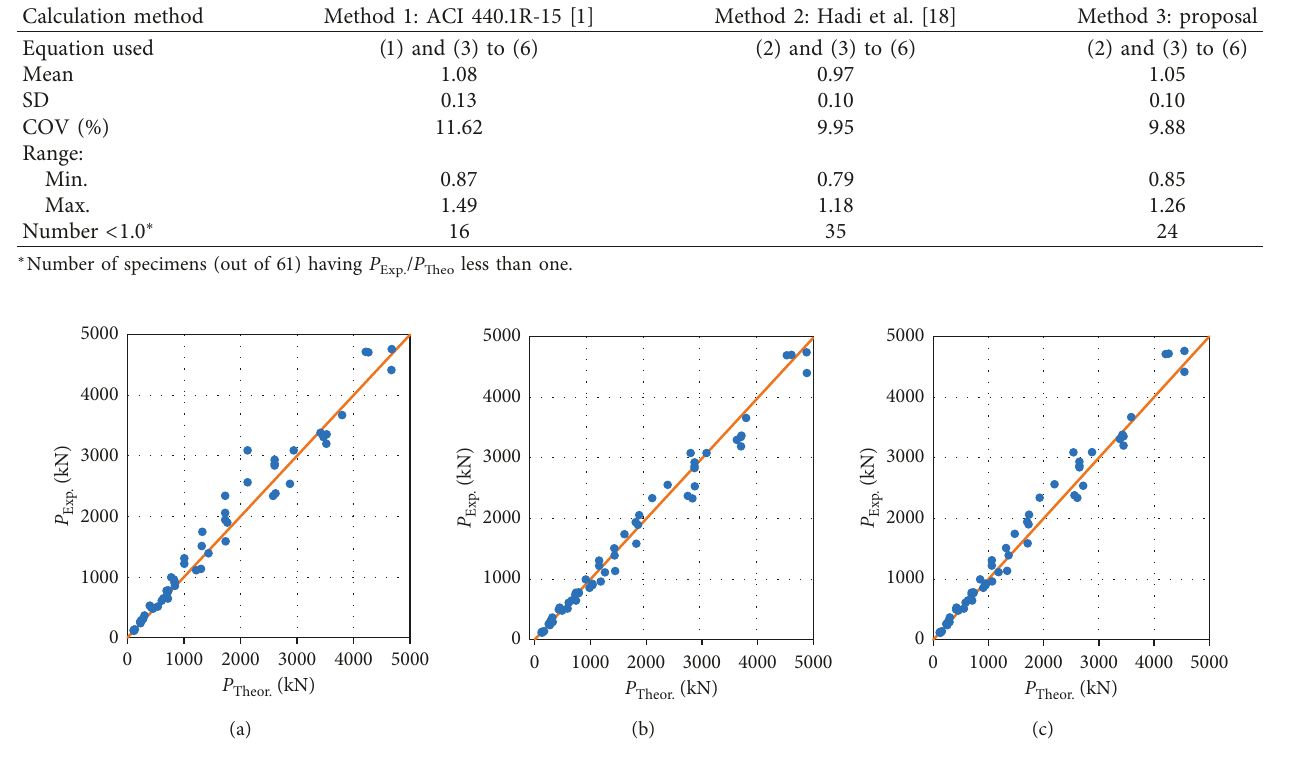
Figure 9: Experimental versus theoretical axial load capacity. (a) ACI 440.1R-15. (b) Hadi et al. [18]. (c) Proposal.